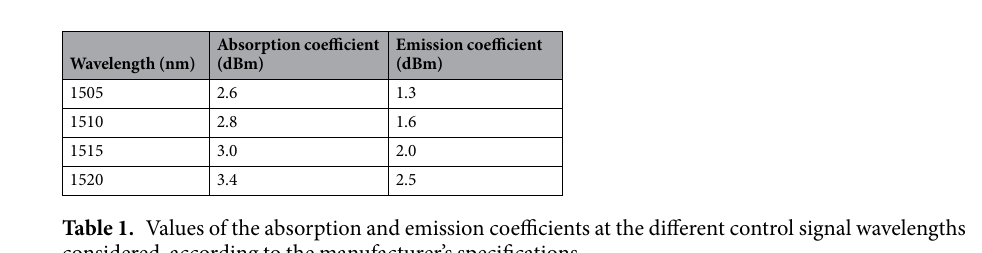
model described in ref. 16. Absorption and emission coefficients have been taken according to the manufacturer’s specifications (Table 1). The transmission factor of the ring passive part (transmission of all the elements except the active fiber plus transmission of the active-passive fiber splices) has been estimated in 0.11 and the lifetime of the 4 I 13/2 level of the Er 3 + ion is 10.5 ms. For the calculations, we also need the radius of the doped transversal area in the active fiber. As the manufacturer does not provide this information, we have tried several values. Here we present the results obtained with a radius of 3.75 μ m. The other parameters in the numerical simulations have been specified in the previous experiment section. We choose the threshold of pump power is 65 mW (no control signal is injected). So, in order to reproduce the experiment shown in Fig. 2, we consider a case that the pump power slightly lower than the threshold: we tune pump power to 62 mW. From Fig. 4, we can see the results are agreed very well with experimental results in Fig. 2. The effect of the pump power on the width of the bistable region has also been numerically simulated in Fig. 5. As shown in Fig. 5, one can find the numerical results are the same as in the experimental results in Fig. 3 (the wavelength of the control signal has been fixed at 1515 nm). The numerical results provide a clear explanation of the OB observed. Each laser response in CW regime takes place after a transient stage. When all the laser inputs (pump and control power) are stable along time, the laser adopts a certain population distribution and there is a balance between emission and absorption at every point along the fiber. If the power of control signal is changed, the balance is suddenly altered and the population distri- bution experiences a transient stage until the system reaches a new balance. It is not surprising that the final state of the transient depends on its initial conditions, provided that the EDFL is a strongly nonlinear system, which is clear according to the model explained in ref. 16.